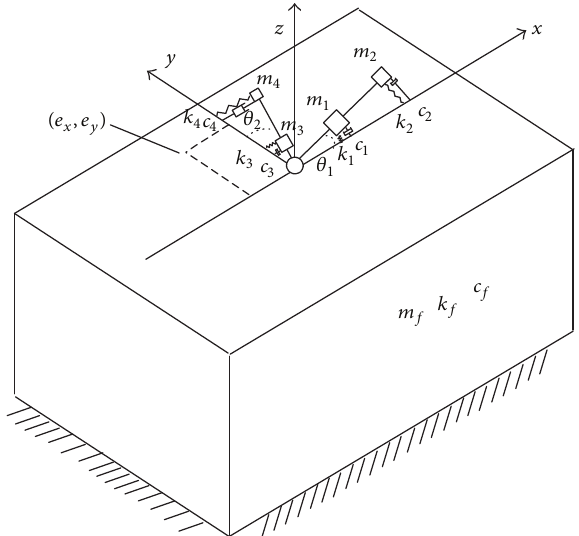
Figure 2: Equivalent dynamic system of eccentric structure with